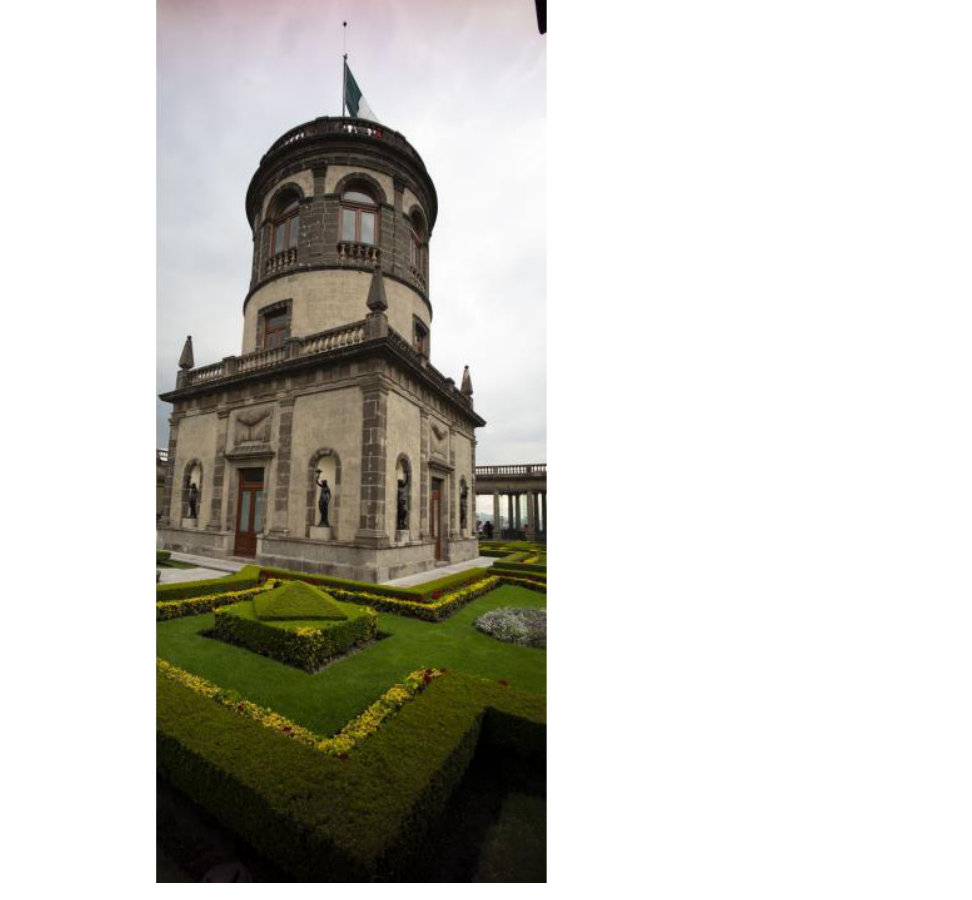
Figure 2. Castle of Chapultepec. Resource: https://www.turismo.cdmx.gob.mx/storage/app/media/Docs/Anuario%20estadistico%20Turismo%2020.pdf (accessed on 5 November 2022).